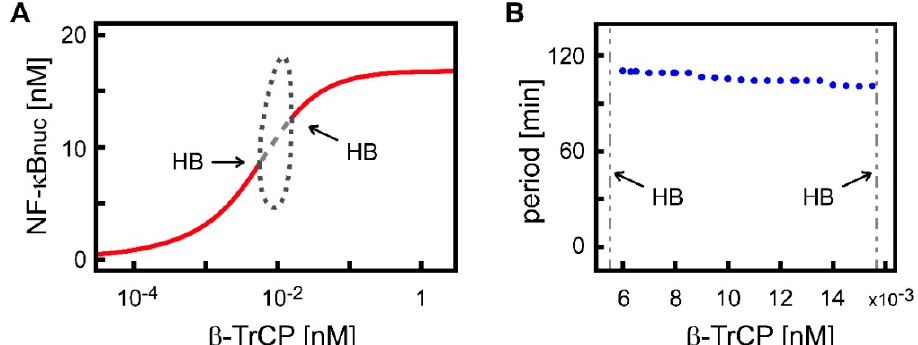
Figure 3. Bifurcation analysis of the stimulated steady state of nuclear NF- κ B with respect to β -TrCP abundance. ( A ) β -TrCP abundance influences the stimulated steady-state concentration of nuclear NF- κ B and the stability of this steady state. The thick red lines denote stable stimulated steady states of nuclear NF- κ B (NF- κ Bnuc). The grey dashed line denotes unstable stimulated steady states. The dotted lines show minimal and maximal values of the amplitude of stable limit cycle oscillations occurring between the two Hopf bifurcation (HB) points at approximately 5.5 × 10 − 3 and 1.6 × 10 − 2 nM. ( B ) Calculated period length of the limit cycle oscillations simulated for selected values of β -TrCP concentrations between the Hopf bifurcation points (indicated by dashed grey lines). The period hardly changes for the considered values of β